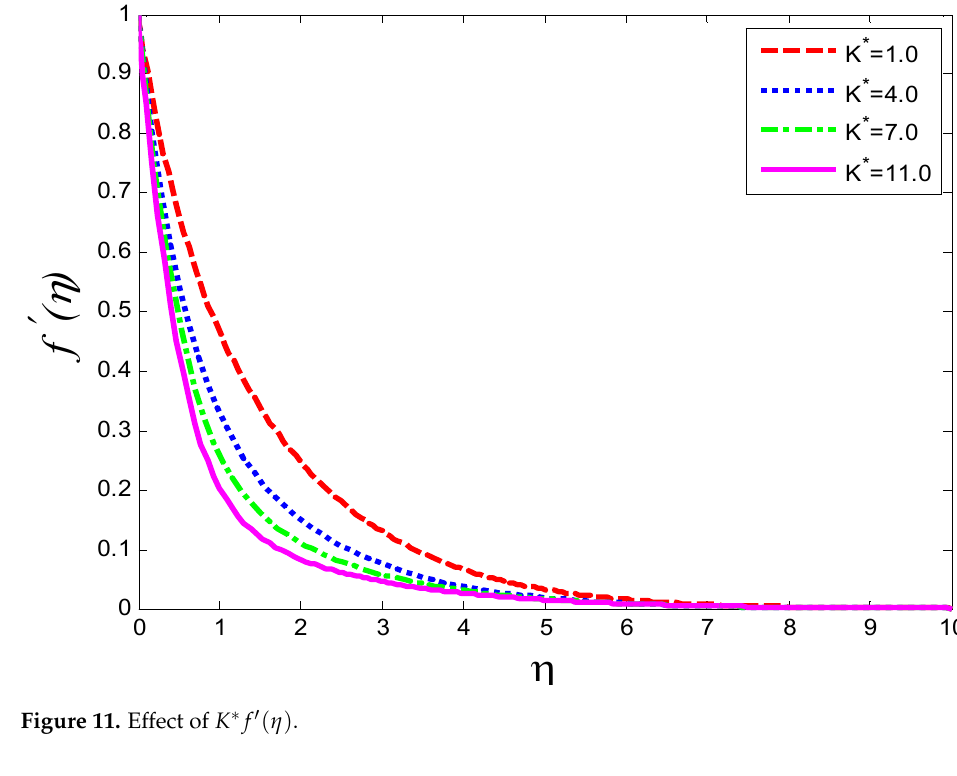
Figure 11. Effect of K ∗ f (cid:48) ( η ) .